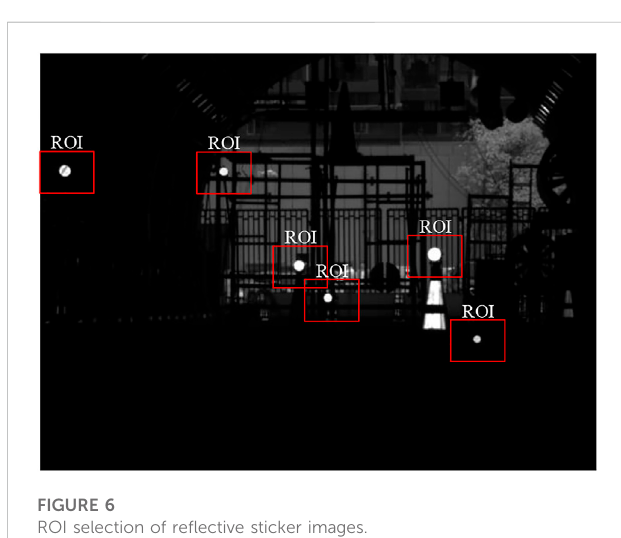
FIGURE 6 ROI selection of re fl ective sticker